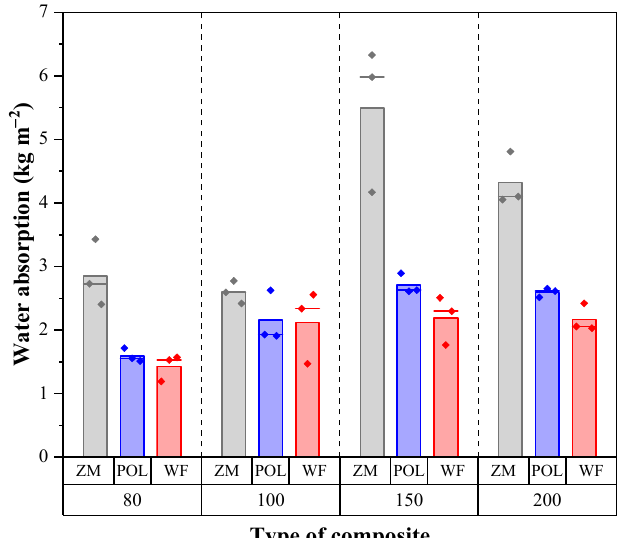
Figure 5. Water absorption of insulation boards of various densities. The height of the column represents the mean value, the vertical line on each column represents the standard deviation, and the dots represent individual data.